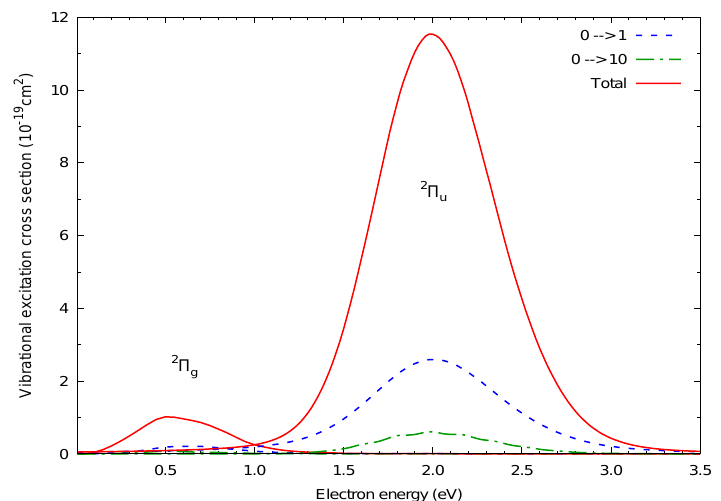
Figure 6. VE cross sections obtained for the 2 Π g and 2 Π u symmetries. Dashed and dashed-dotted lines show the ν = 0 → 1,10 results and the solid line shows total VE cross section,